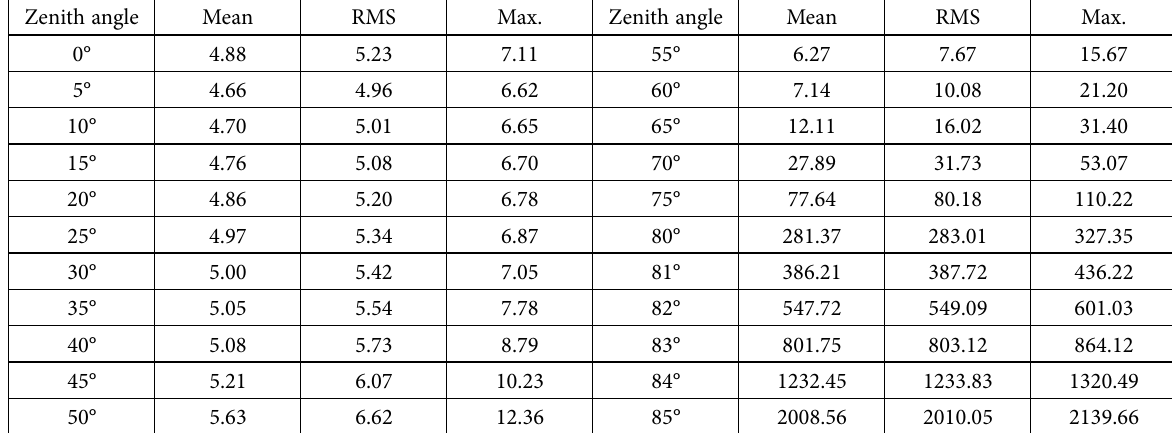
Table 2. Mean tropospheric delay difference (mm) between new equations and NIM Zenith angle Mean RMS Max. Zenith angle Mean RMS